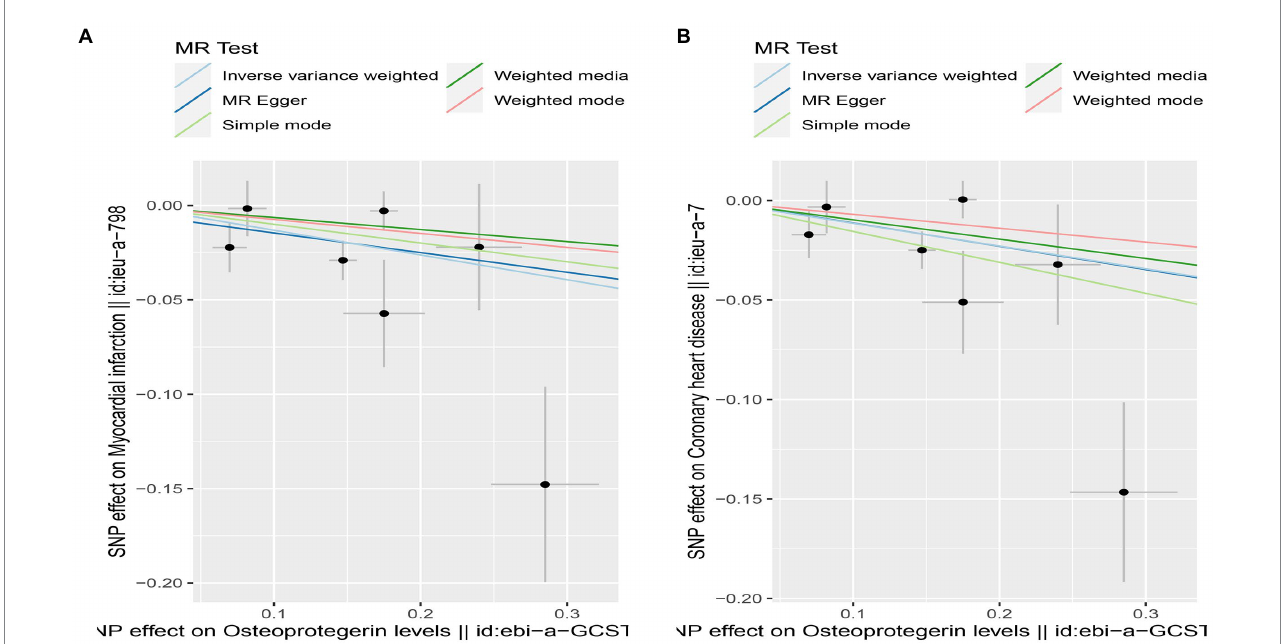
FIGURE 5 Scatterplot of MR estimates of genetic risk of OPG on AMI and CHD. Scatter-plot of genetic effects on OPG versus their effects on AMI (A) and CHD (B) with corresponding standard errors denoted by horizontal and vertical lines. The slope of each line corresponds to the estimated MR effect from different methods.